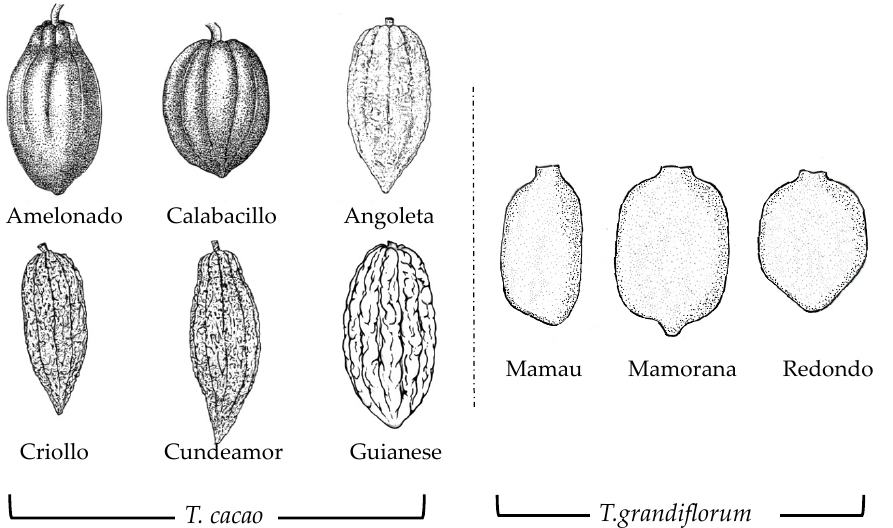
Figure 2. Representation of cocoa (adapted with permission of P. Lachenaud, Biotope Editions, 2022, [39]) and cupuassu pod shapes. Data from [2,38–40].